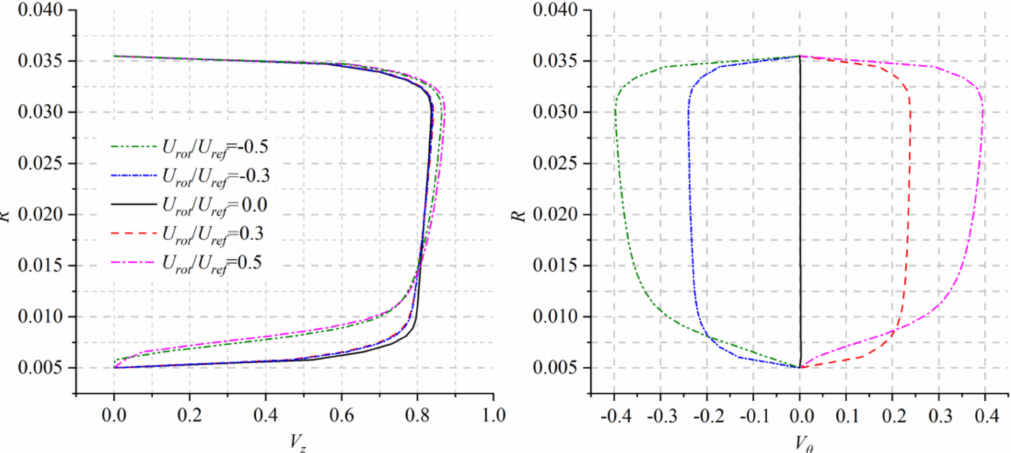
Figure 4. Distributions of axial velocity (V z ) and circumferential velocity (V θ ) at the exit of the inflow